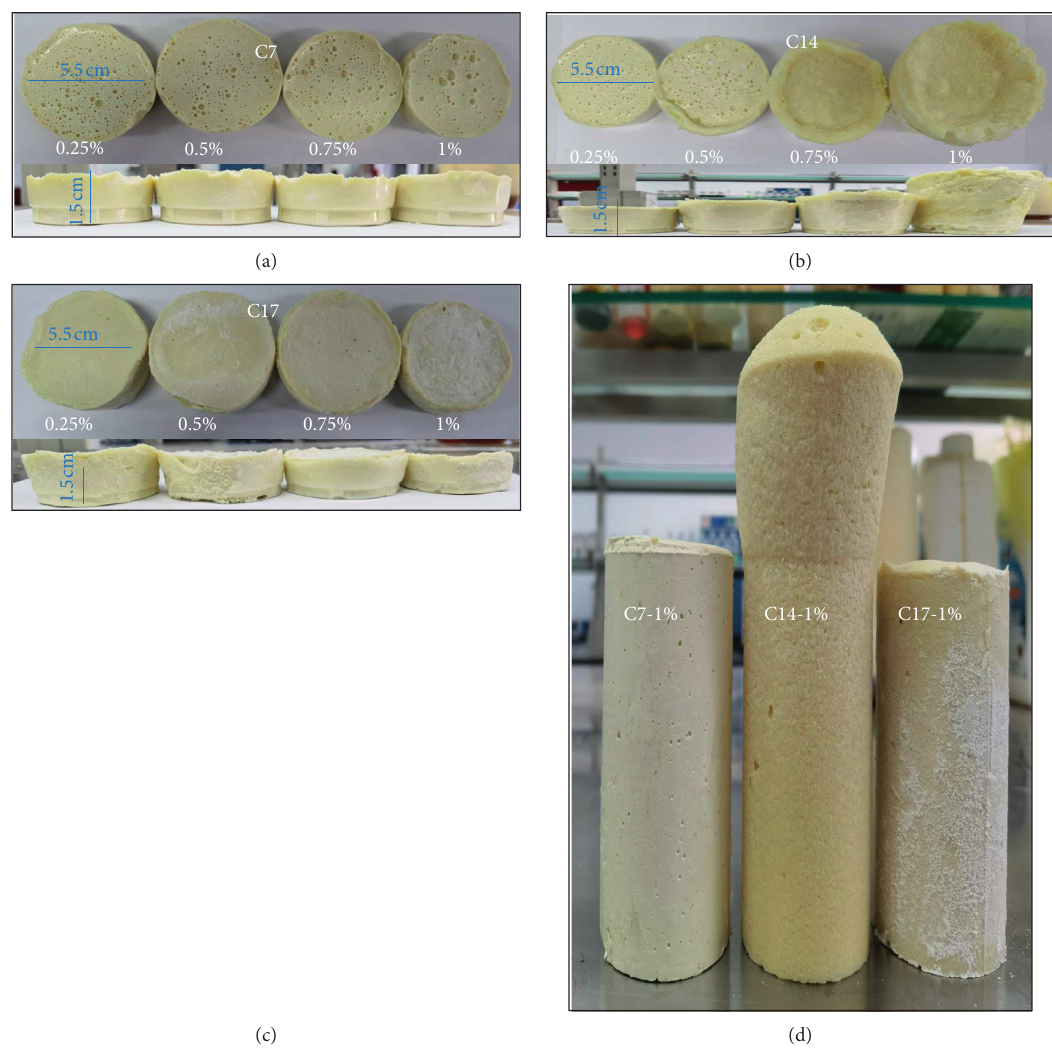
Figure 3: The morphologies of samples catalyzed by different types and additive number of